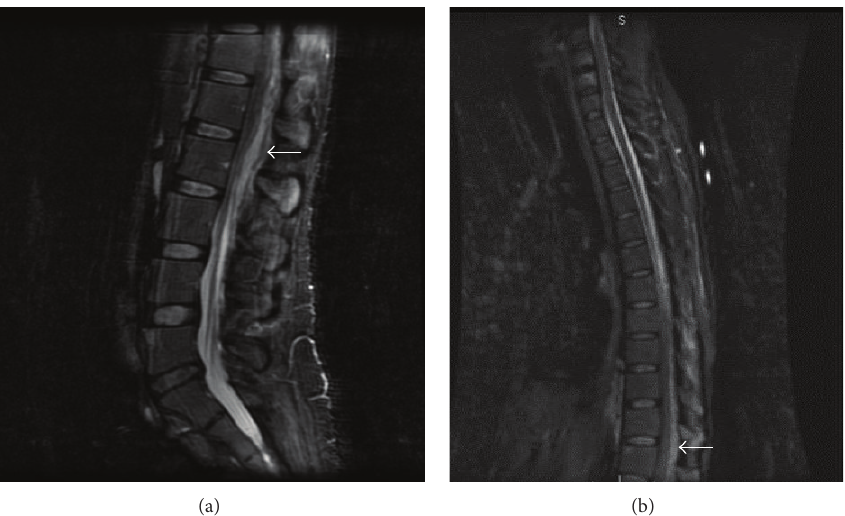
Figure 1: MRI of the lumbosacral spine (panel (a)) and thoracic spine (panel (b)), sagittal view: complex posterior epidural collection extending from lumbar L4 level cephalad into thoracic T7 associated central canal compromise and findings consistent with epidural abscess.